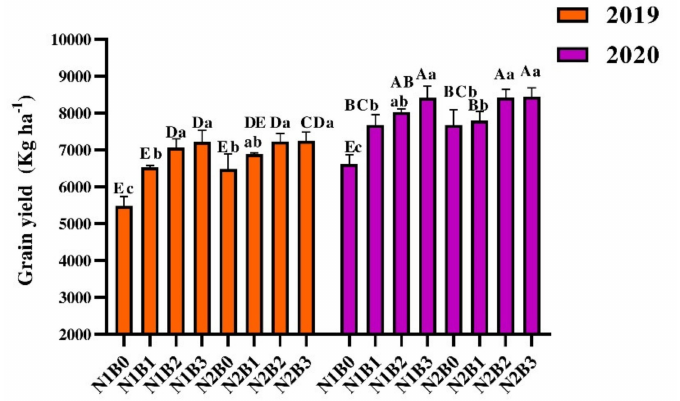
Figure 2. Effect of biochar and nitrogen fertilizer on grain yield. Bars represent the standard errors of the means. Different small and capital letters show significant differences between the treatments within the same year and between the years in the same treatment, respectively, via LSD test at p ≤ 0.05. N1 and N2 represent 135 and 180 kg ha − 1 nitrogen; B0, B1, B2, and B3 represent 0-, 10-, 20-, and 30-ton biochar ha − 1 .